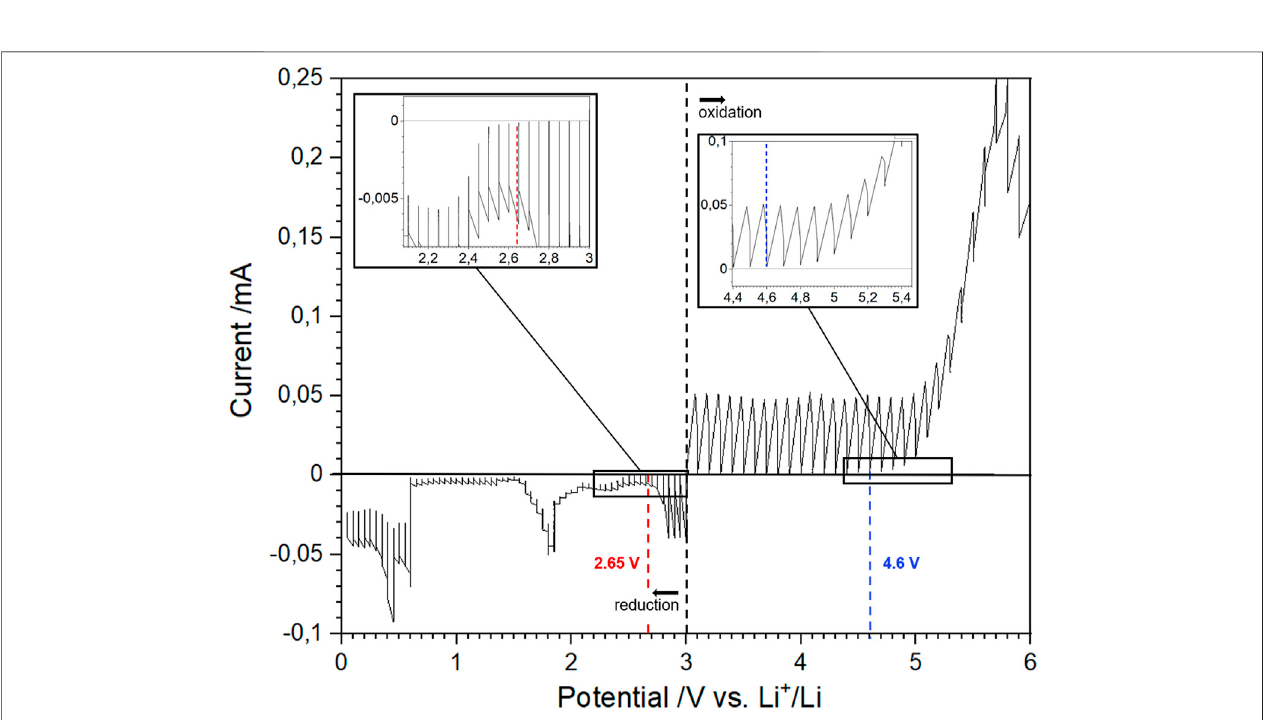
FIGURE 4 | PITT measurements on a stack LATP-Au/LATP. The two measures were taken on two distinct stacks at 60 ° C, from E oc to 6 V for oxidation and from E oc to 0 V vs. Li + /Li for reduction. A potential step of 50 mV, a current limit of 10 nA and a time limit of 3 h were used.